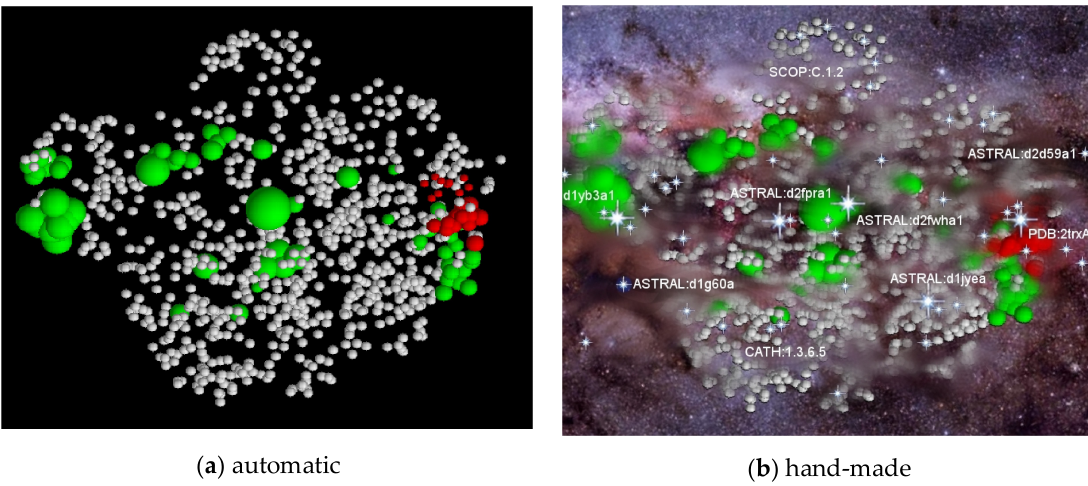
Figure 6. A fragment of fold space: ( a ) The model folds generated from the secondary structure sequence for a small protein is shown with each structure represented as a dot in a projected space (as in Figure 2). The known family from which the SSE sequence was taken is coloured red, and the model structures that correspond to other known folds are coloured green. The size of the coloured spheres is proportional to the number of family members. ( b ) The greater number of novel folds (white) has been likened to the preponderance of dark matter in the Universe.